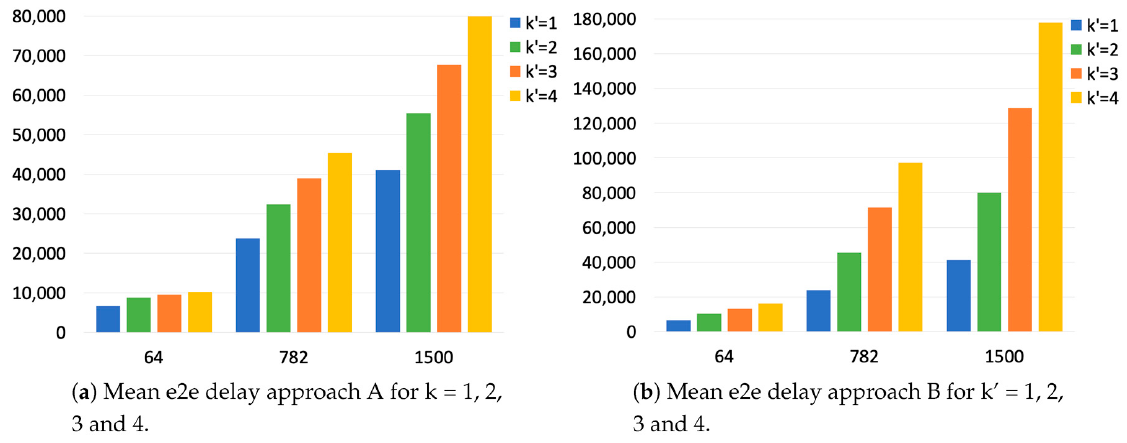
Figure 16. Mean value for the maximum end-to-end delay for approaches A and B with k = k’ = 1, 2, 3 and 4. The X axis represent the frame length in bytes, while the Y axis represent the end-to-end delay in nanoseconds.